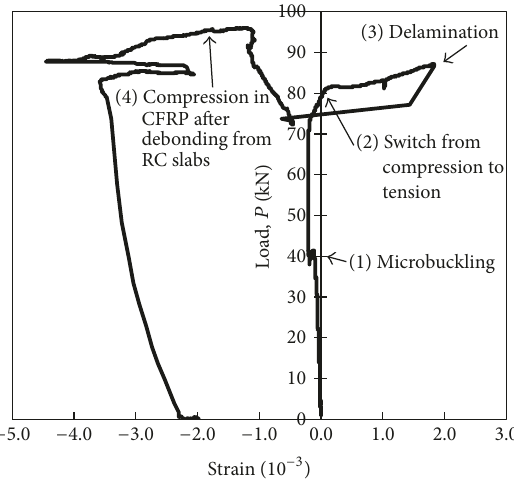
Figure 8: Strain evolution in